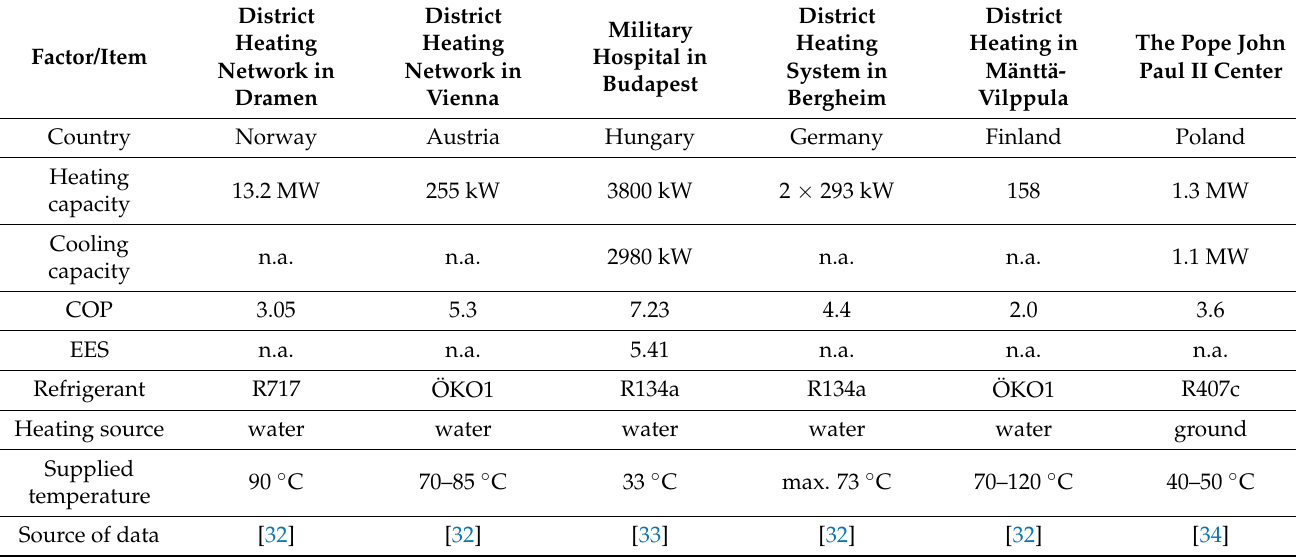
Table 3. Examples of various applications of high-capacity heat pumps in